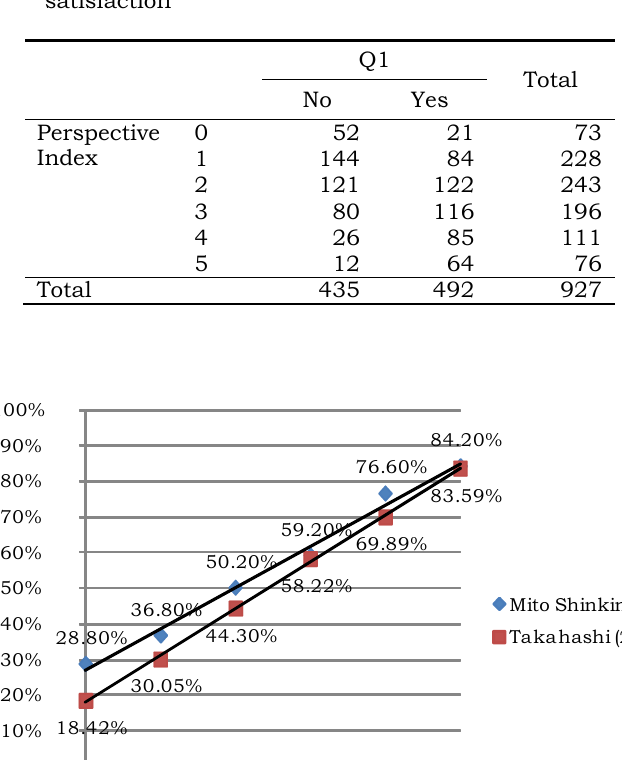
Table 2. Cross table of perspective index and job